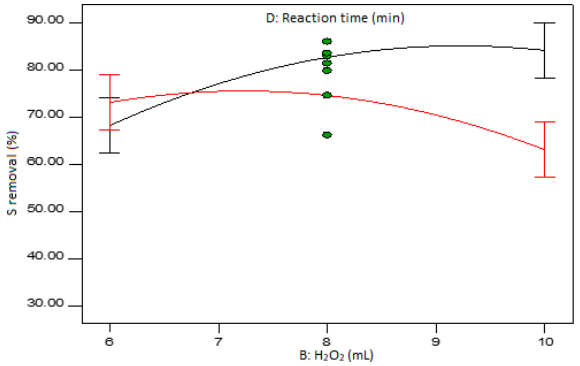
Figure 9: Interaction plot of hydrogen peroxide amount and reaction time at mid-level temperature and formic acid amount.